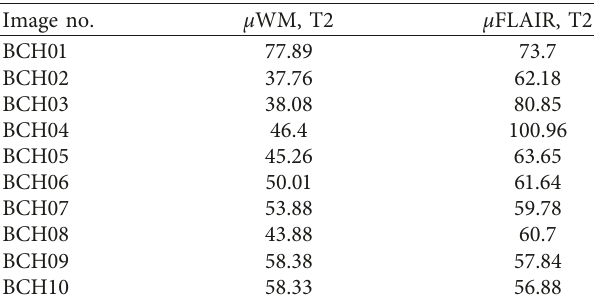
Table 2: Parameters of means obtained for the white matter. Image no.